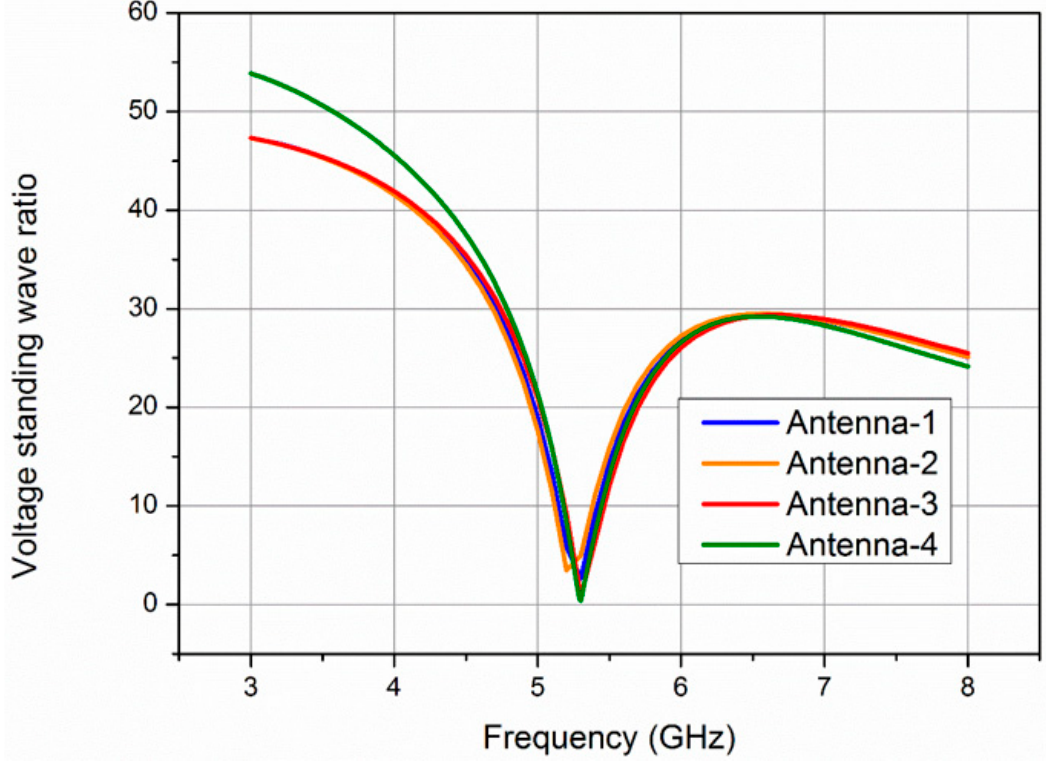
Figure 5. Presents voltage standing wave ratio of the proposed Antenna-1, Antenna-2, Antenna-3, and